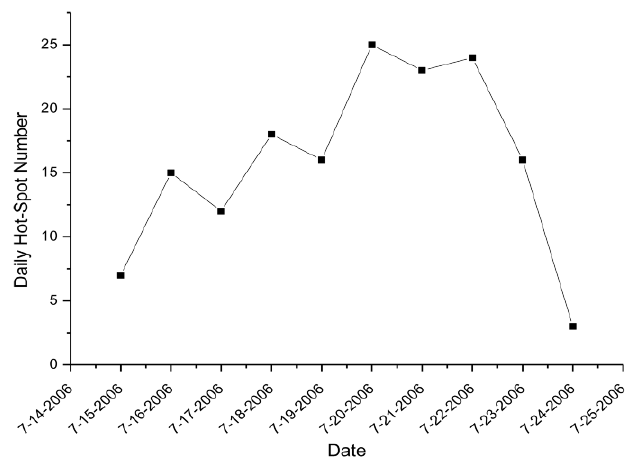
Figure 3. Time series of the number of daily hot-spots detected by RST through the analysis of all of the MODIS data acquired over the VOLC target area (Mount Etna) for the period of July 15-24,